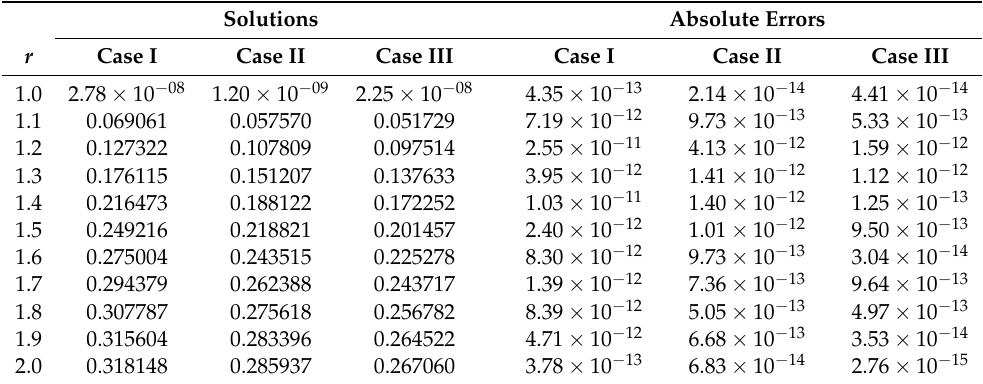
Table 5. Approximate solutions and Absolute errors obtained by the LNN-GNDO-SQP algorithm for SCENARIO III of the drainage problem.